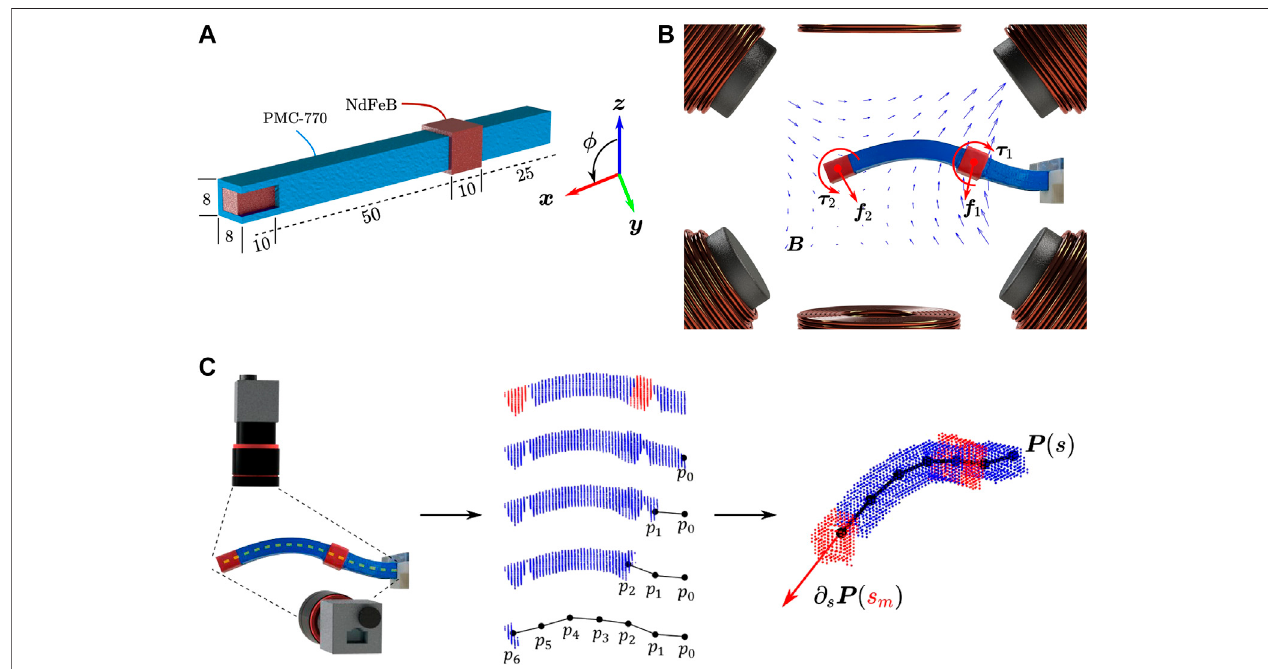
FIGURE 9 | (A) : Polymer matrix composite 770 (PMC-770) beam continuum manipulator with embedded neodymium (NdFeb) magnets located at tip and intermediate positions. Dimensions are given in millimeter. (B) : Experimental setup consists of six stationary electromagnets and contains a segmented photograph of the fi nal shape manipulator. The fl exible PMC-770 and rigid NdFeb sections of the manipulator are blue and red, respectively. Six electromagnets generate a magnetic fi eld ( B ) in the workspace, exerting torques and forces ( τ , f (cid:2) 1 , 2) on the magnets, which deforms the continuum manipulator to its fi nal shape at the time m m , m t (cid:2) 340 s. C : Representation of the shape reconstruction algorithm used for shape feedback. The manipulator is recorded with a stereo vision setup. The manipulator body is represented by a 3D spatial point cloud.The manipulator centerline, characterized byparameter s ∈ [ 0 , L ] , is approximated by N + 1 points ({ p 0 , ... , p N }) . A 3D polynomial fi t ( P ( s )) is made through the points, and the magnet orientation at an assumed constant centerline position s m derived from the local gradient of the polynomial fi